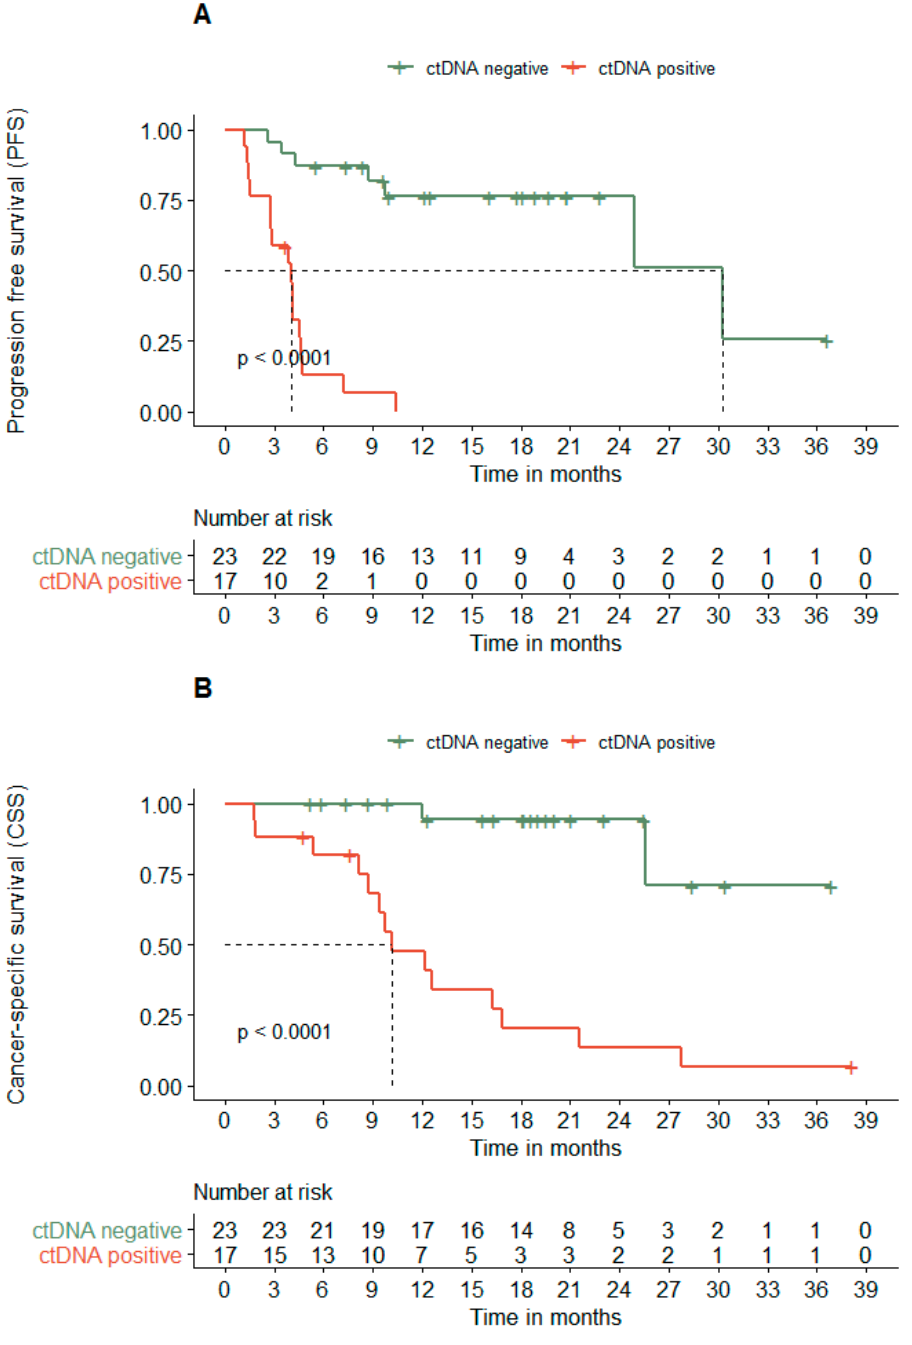
Figure 3. ctDNA dynamics related to ( A ) progression-free survival (PFS) and ( B ) cancer-specific survival (CSS). Patients were stratified according to their ctDNA levels at 12–18 weeks, being either detectable (ctDNA positive) or undetectable (ctDNA negative).